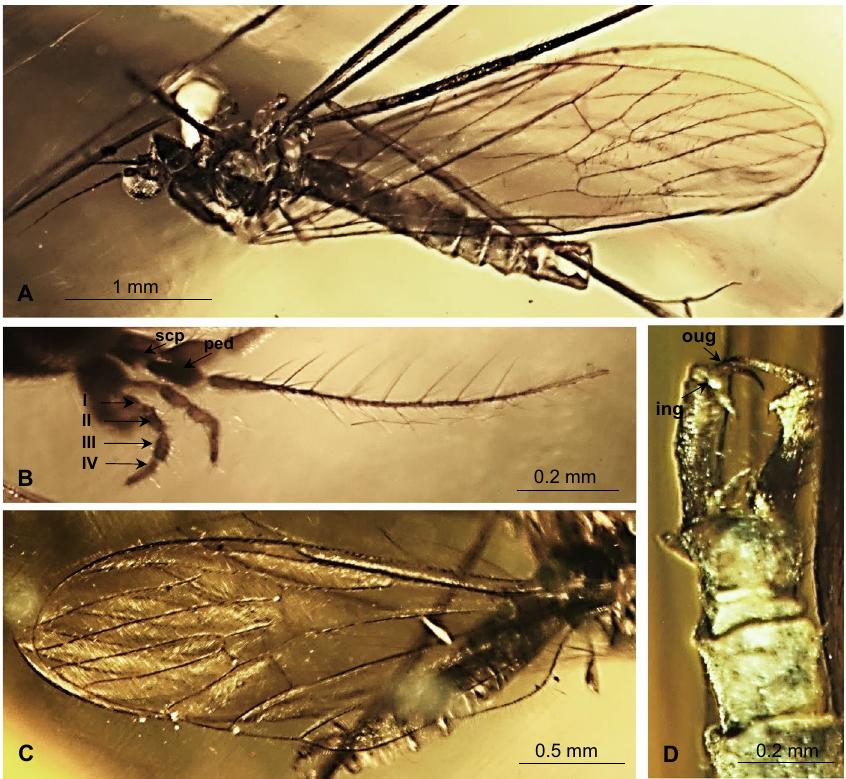
Figure 6. Gonomyia ( Cretagonomyia ) burmitica subgen. et sp. nov. (Limoniidae), inclusions in Kachin amber: ( A ) body, latero-ventral view; ( B ) antenna and palpi; ( C ) wing; ( D )